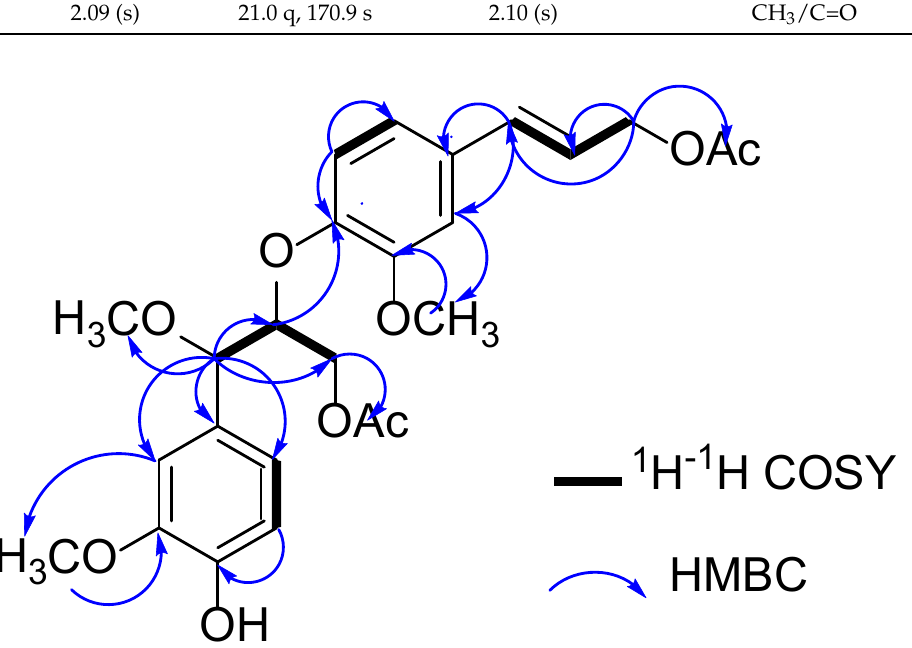
Figure 2. 1 H −1 H COSY (black bold), key HMBC (blue arrows) correlations of compounds 1–2. Figure 2. 1 H − 1 H COSY (black bold), key HMBC (blue arrows) correlations of compounds 1–2